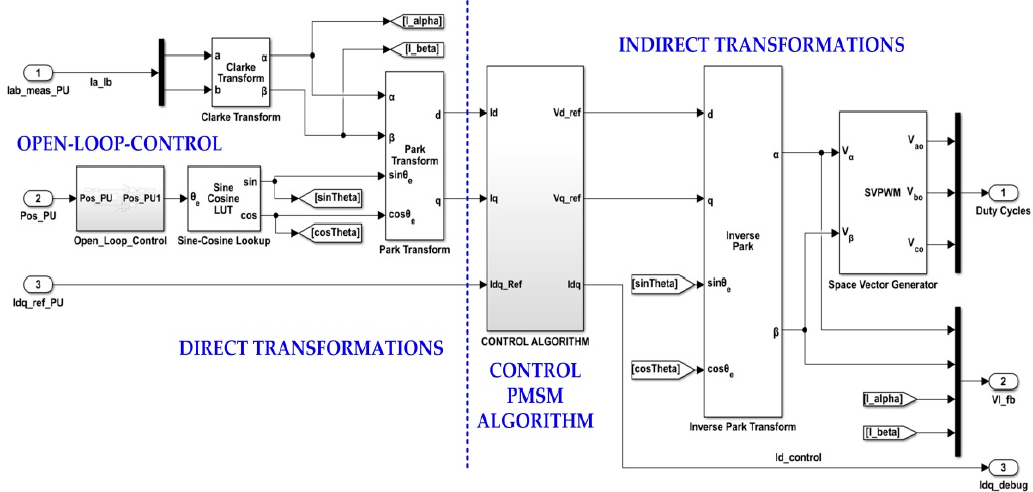
Figure 30. Global real-time software application implementation in MATLAB/Simulink for PMSM control—HIL stage.